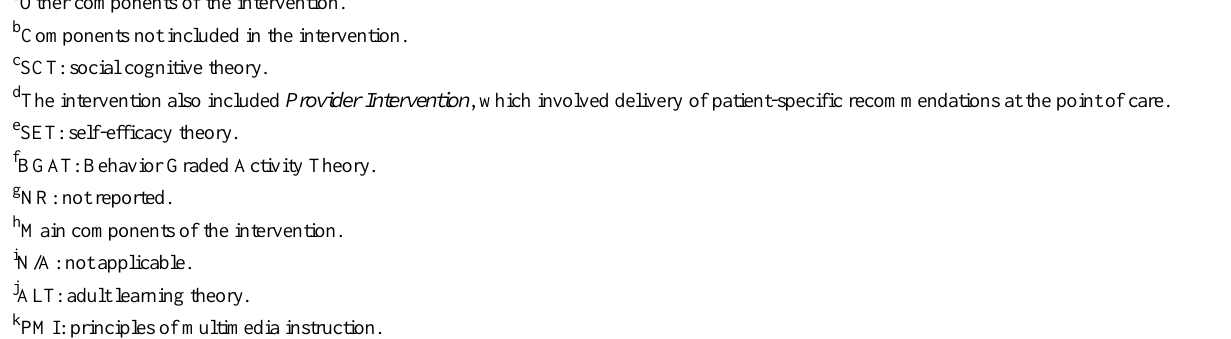
(Table 6; Multimedia Appendix 3). Owing to the heterogeneity in the approaches used, a meta-analysis was not